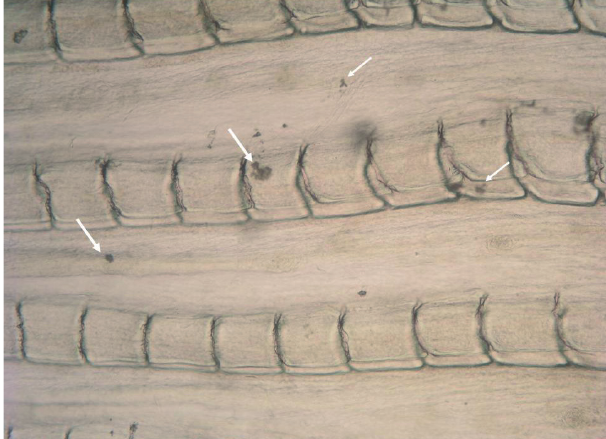
Fig. 2. Detail of the caudal-fin of the same specimen of Stygichthys typhlops after administration of L-DOPA; mela- nophores indicated by arrows. Magnification 200 x.